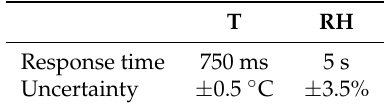
Table 1. Technical features of the T and RH sensors used in the